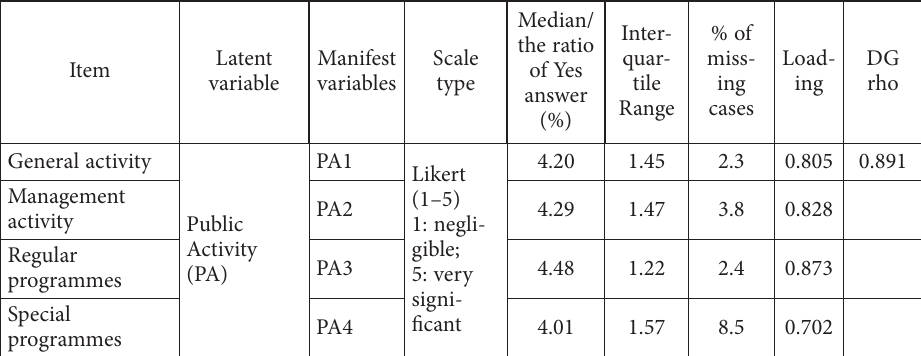
Table 2. Descriptive statistics, loadings and composite reliability of the studied items